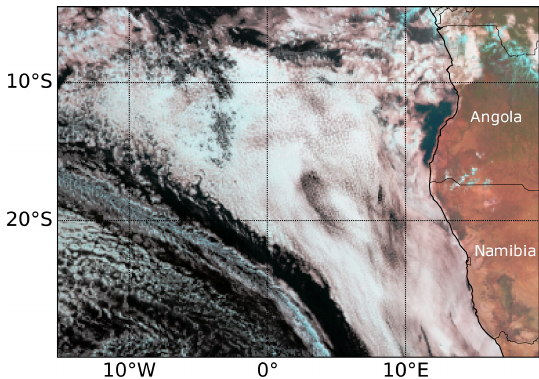
Figure 1. RGB composite obtained from the SEVIRI 0.64 (blue), 0.81 (green) and 1.64µm (red) channels for 4 September 2017 at 10:15UTC over the